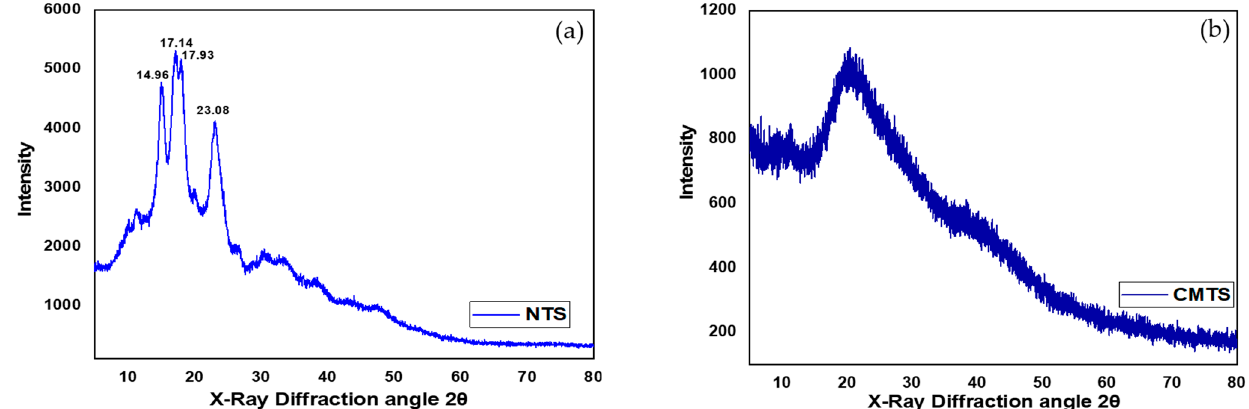
Figure 3. X-ray Diffractograms of ( a ) Native Tapioca Starch (NTS) and ( b ) Carboxymethylated Tapioca Starch (CMTS).